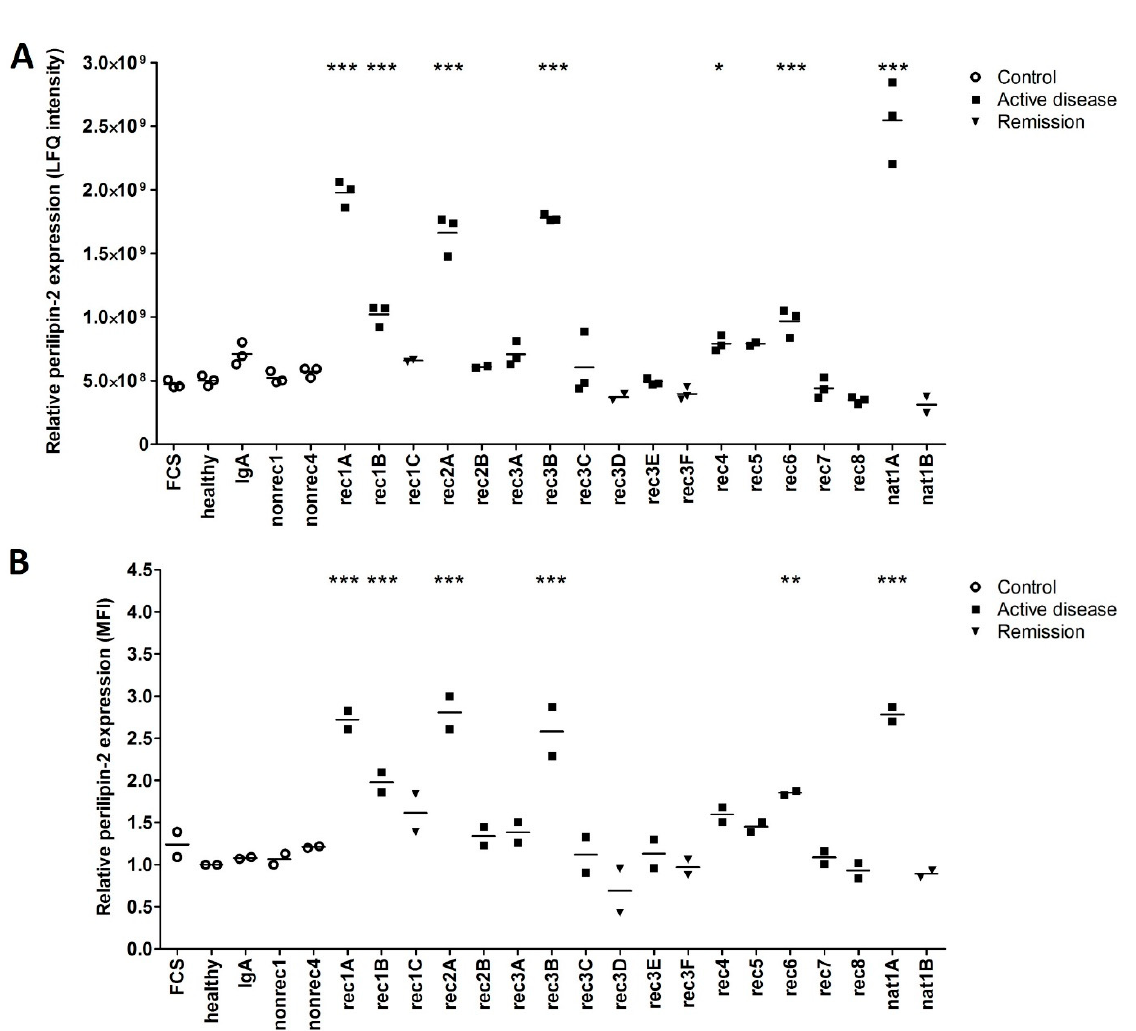
plasmas rec1C and nat1B and healthy plasma did not increase PLIN2 mRNA